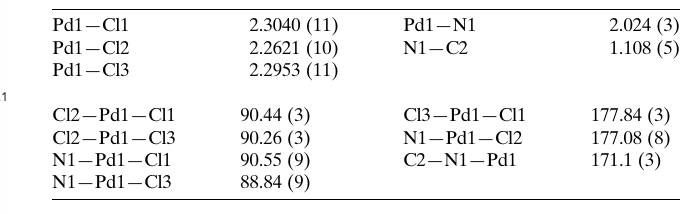
Table 1 Selected geometric parameters (A˚ , (cid:3) ).